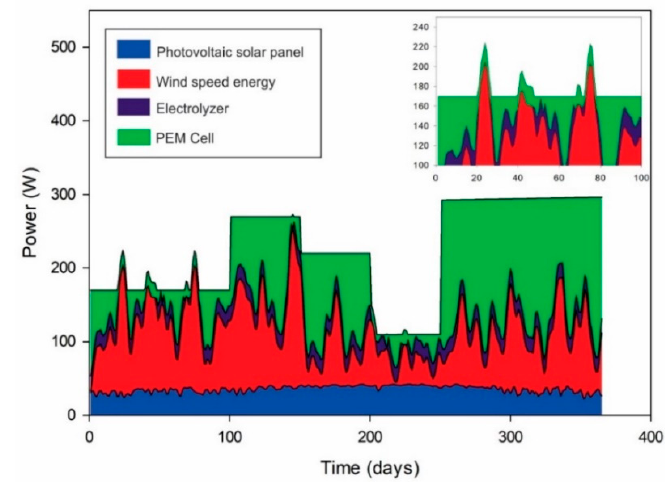
Figure 12. Power in Texas (USA).